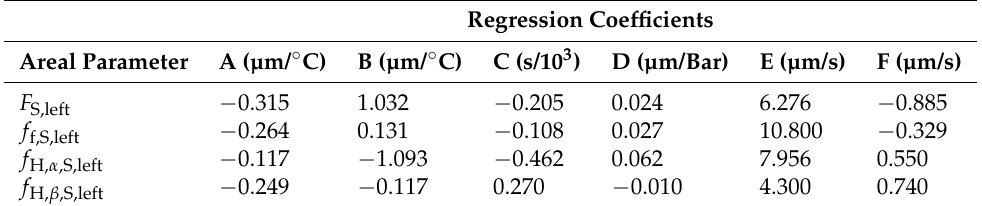
Table 7. The coefficients of the linear regression for the target areal